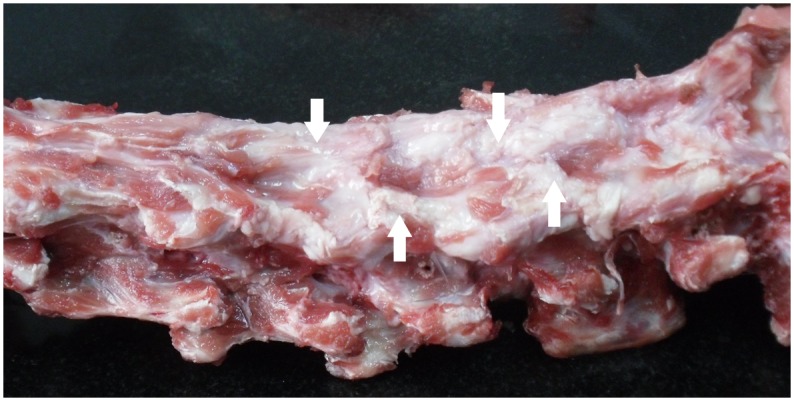
Gross anatomy performance of the cervical spine six months after surgery.Photograph depict appreciable abundant fibrous tissue formation round the facet joints and re-implanted lamina-ligamentous complex (arrows).